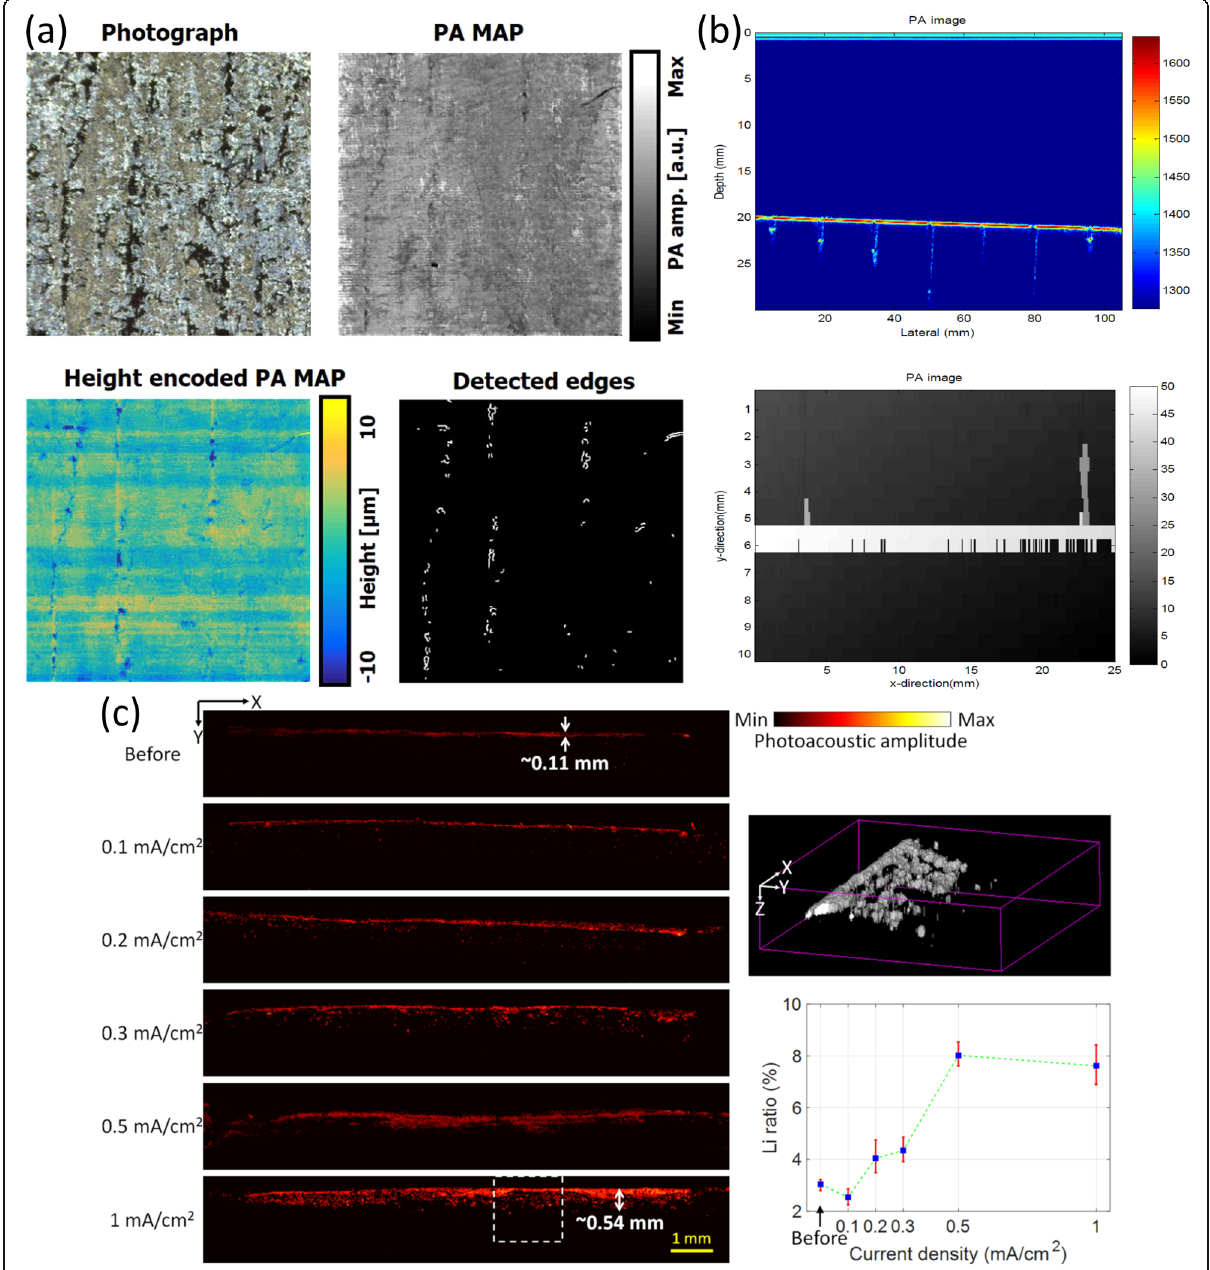
Fig. 3 Representative applications of metal using PA technologies for NDT/E. ( a ): Detected edge of the seam crack surface by OR-PAM images [42]; ( b ): PA images of high-speed rail surface cracks: rail head (top) and rail web (bottom) [38]; ( c ): Li deposition of Li/Li cell samples imaged using OR-PAM. Li metal electrode of Li/Li cell samples before and after charging at different current densities (left), representative 3D visualization of the case of 1 mA/cm 2 (top-right), and quantitative analysis of Li deposition (bottom-right)